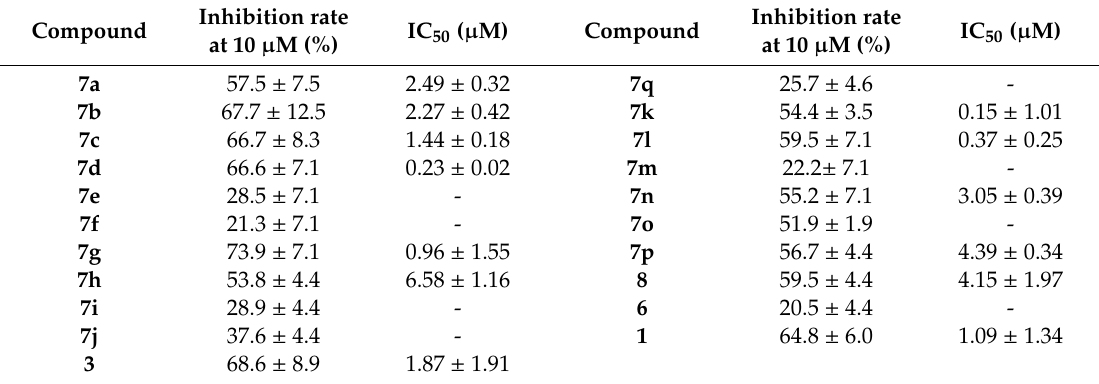
Table 4. The enzyme activity of Series III compounds.